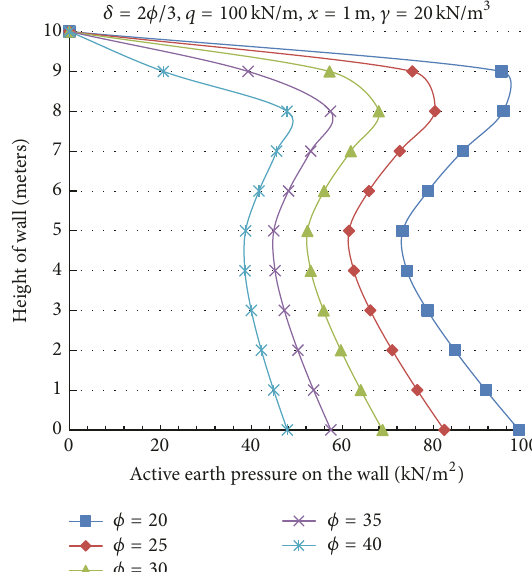
Figure 9: Total active pressure distribution on the wall for different values of the angle of internal friction.